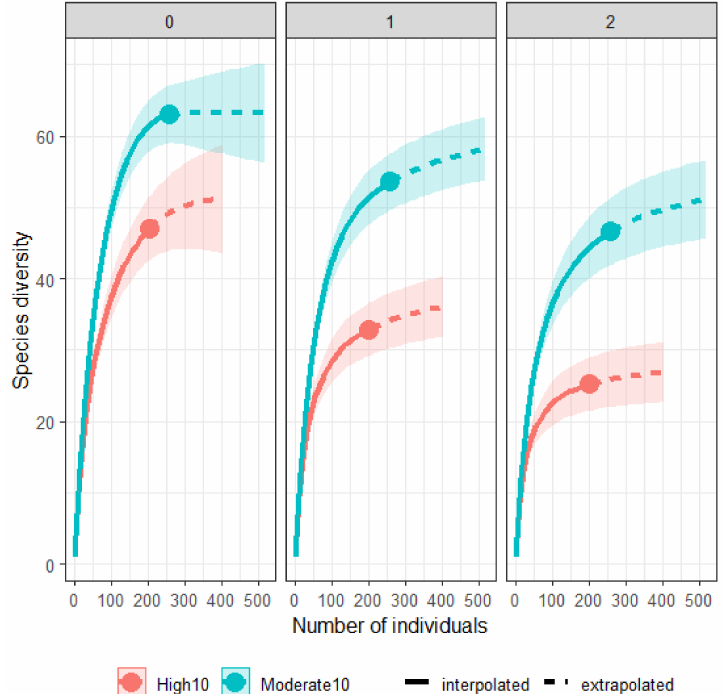
Figure 8. Comparison of tree species biodiversity between high and moderate utilization regimes after 10 years of abandonment based on Hill numbers for different orders (0, 1, and 2). The solid and dotted lines represent the rarefaction and extrapolation curves, respectively. The shaded area indicates the confidence interval at 95%, based on bootstrap method with 200